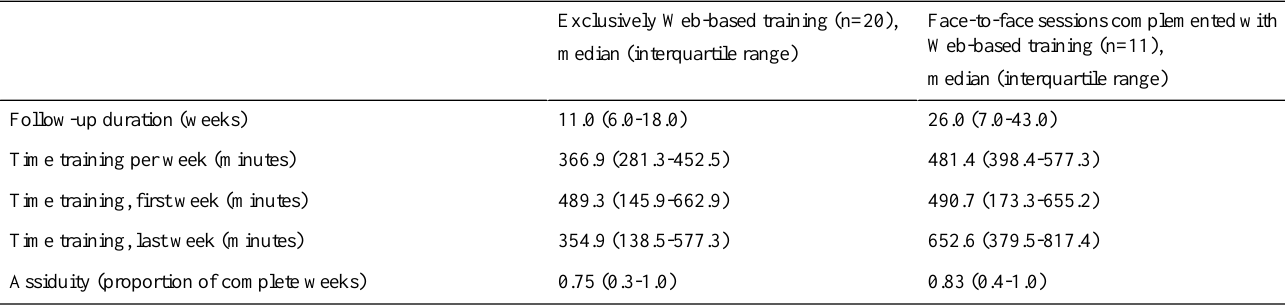
Table 4. Indicators of intensity and adherence to treatment per major type of treatment strategy.